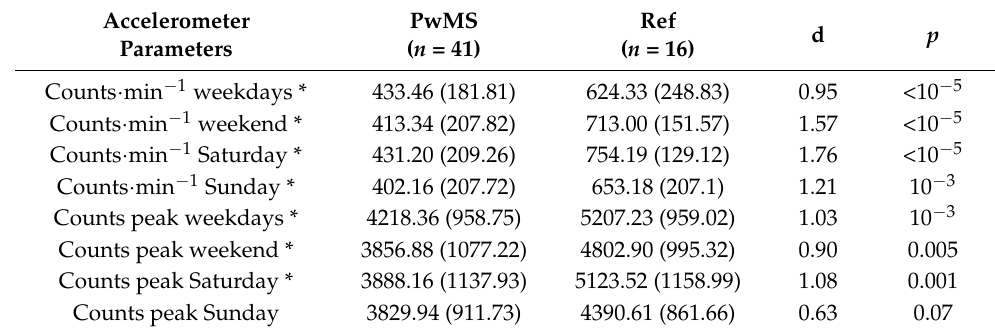
Table 3. Comparisons between MS and the Reference groups for the level of physical activity (Mean and SD for counts · min − 1 and peak) on the weekdays, weekend, Saturday and Sunday.